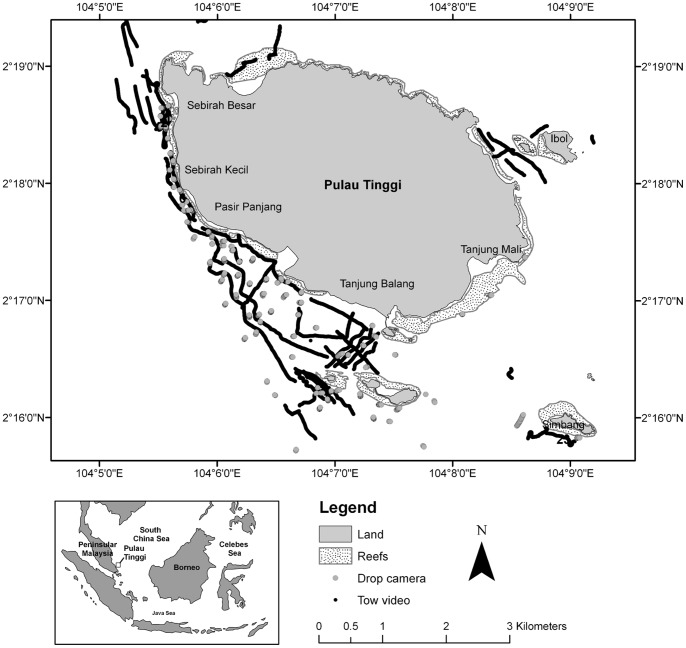
Location of tow video, drop video, and seagrass sampling points around Pulau Tinggi, southeast Peninsular Malaysia.Tow video points have converged to form tracks.